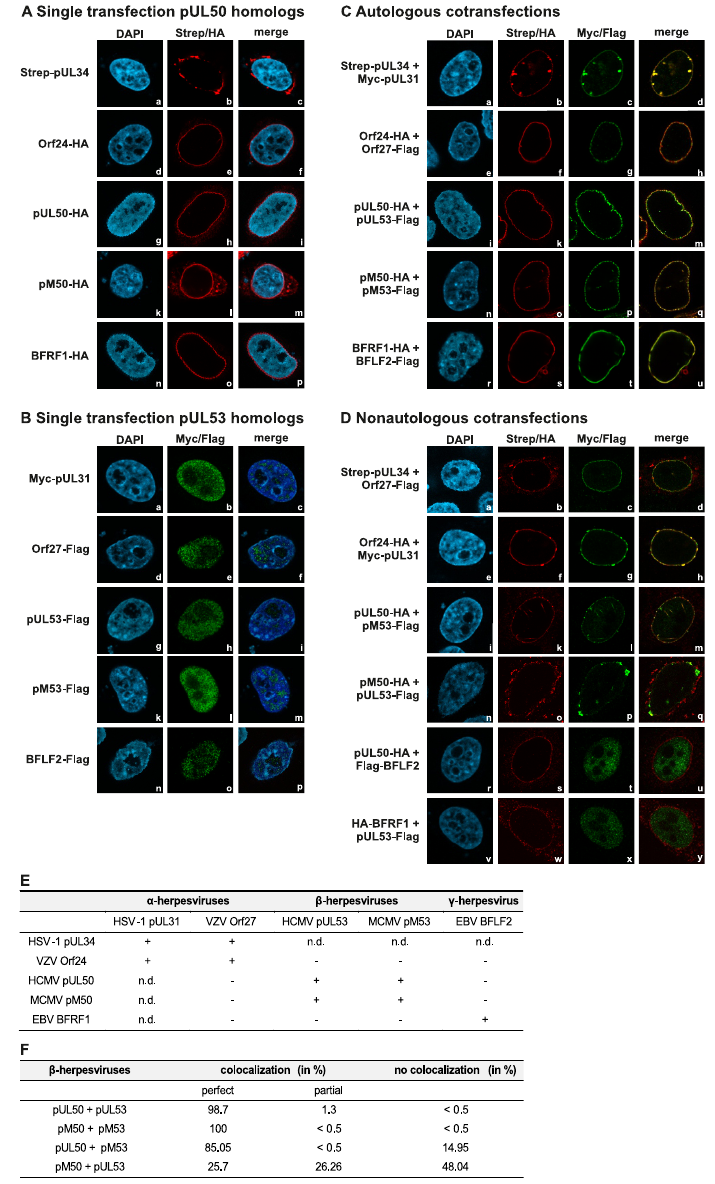
Figure 4. Coexpression of autologous pairs of HSV-1, VZV, HCMV, MCMV and EBV core NEC proteins show perfect nuclear rim colocalization, while nonautologous colocalization is restricted to subfamily-related proteins. HeLa cells were transiently cotransfected with constructs coding for Strep-pUL34, HA-tagged Orf24, pUL50, pM50 and BFRF1 or Myc-pUL31, Flag-tagged Orf27, pUL53, pM53 and BFLF2. Two d p.t., cells were fixed and used for immunostaining with tag-specific antibodies analyzed by confocal imaging. DAPI counterstaining indicated the morphology of nuclei of the respective cells. Single expression of ( A ) pUL50 homologs localized on the nuclear rim and ( B ) pUL53 homologs distributed in the nucleus. ( C ) Colocalization of coexpressed autologous NEC protein pairs on the nuclear rim. ( D ) Coexpressed, colocalizing nonautologous NEC protein pairs of subfamily-related proteins. ( E ) Combined results of autologous and nonautologous combinations. n.d., not determined. ( F ) Quantitation of autologous and nonautologous colocalization of HCMV and MCMV nuclear egress proteins presented as